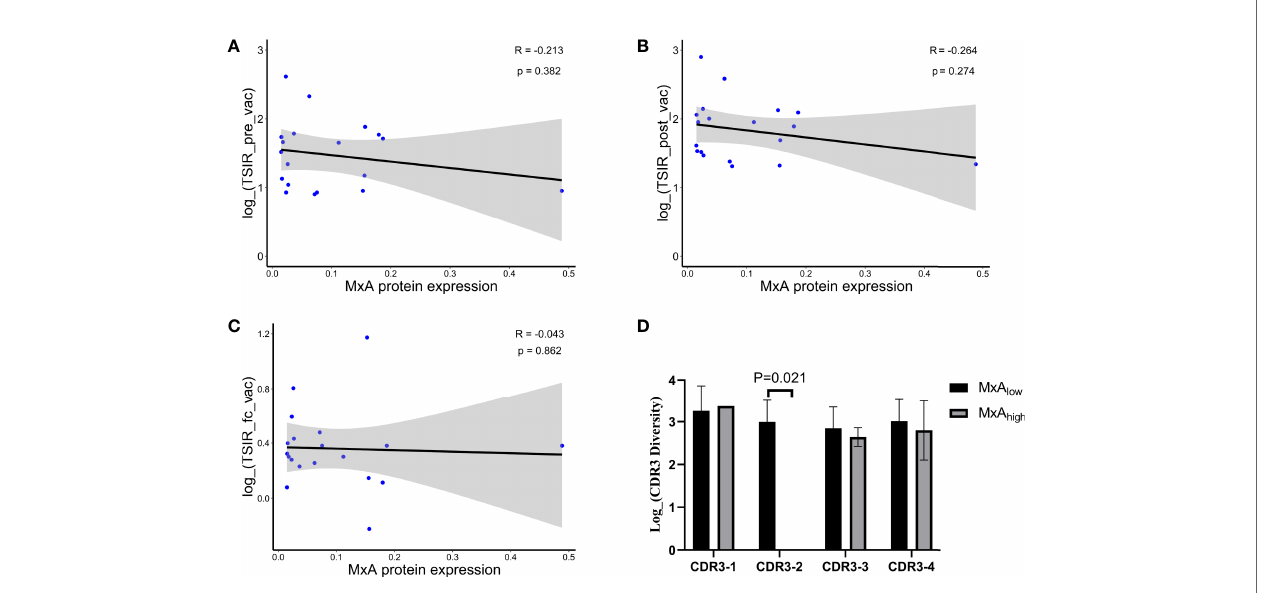
FIGURE 4 | Association of MxA expression with prognosis linked to a preexisting TCR clone but was independent of TSIR. Pearson correlation of the expression of MxA protein with TSIR pre-vaccination (A) , TSIR post-vaccination (B) , and fold change of TSIR from pre- to post-vaccination (C) in 19 vaccinated patients. (D) Comparison of TCR clonotypes speci fi c for long-term survivors between the high MxA protein expression group (MxA high: expression of MxA protein > the median value) and the low MxA protein expression group (MxA low: expression of MxA protein ≤ the median value), Wilcoxon nonparametric test. Continuous data were compared using the Wilcoxon nonparametric test.